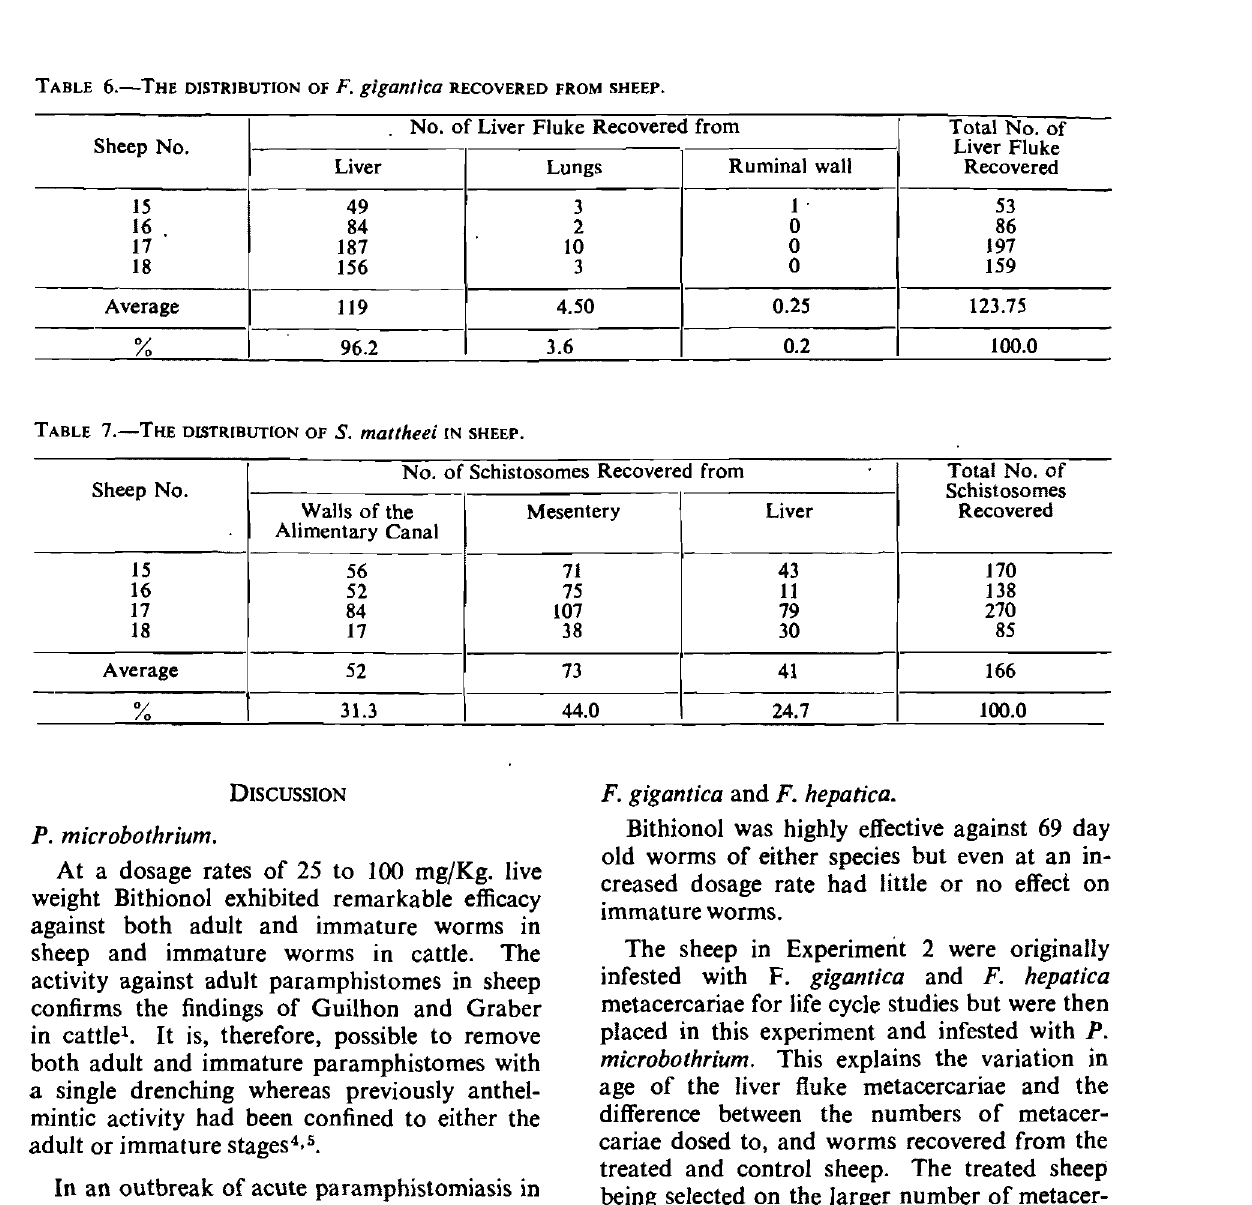
TABLE 7.-THE DISTRIBUTION OF S. mattheei IN SHEEP. No. of Schistosomes Recovered from Total No. of Sheep